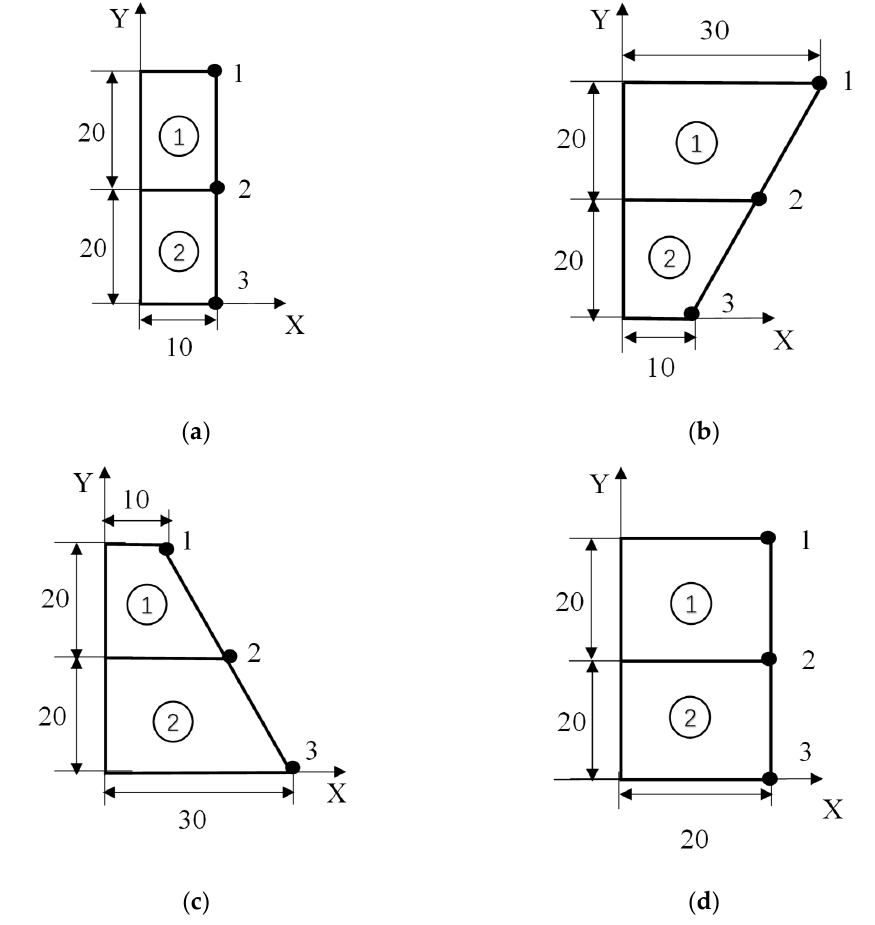
Figure 15. An example for independence of basis vectors. ( a ) Original shape, ( b ) Basis shape 1, ( c ) Basis shape 2, ( d ) Basis shape 3.